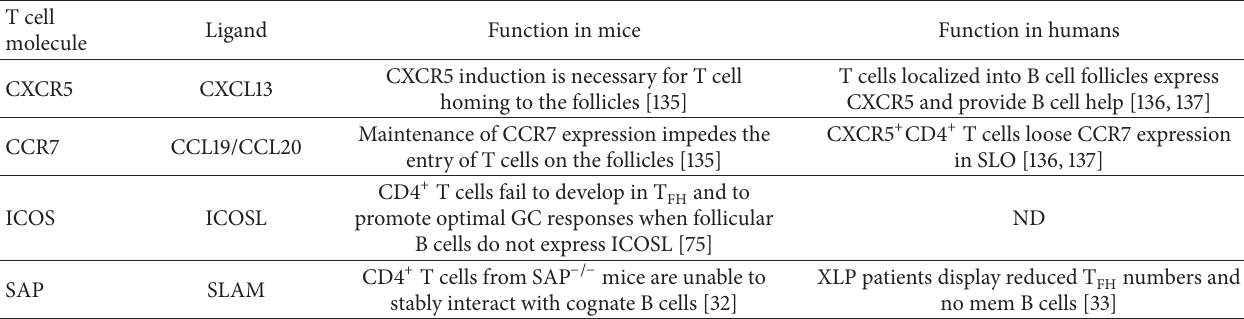
-related molecules during T FH